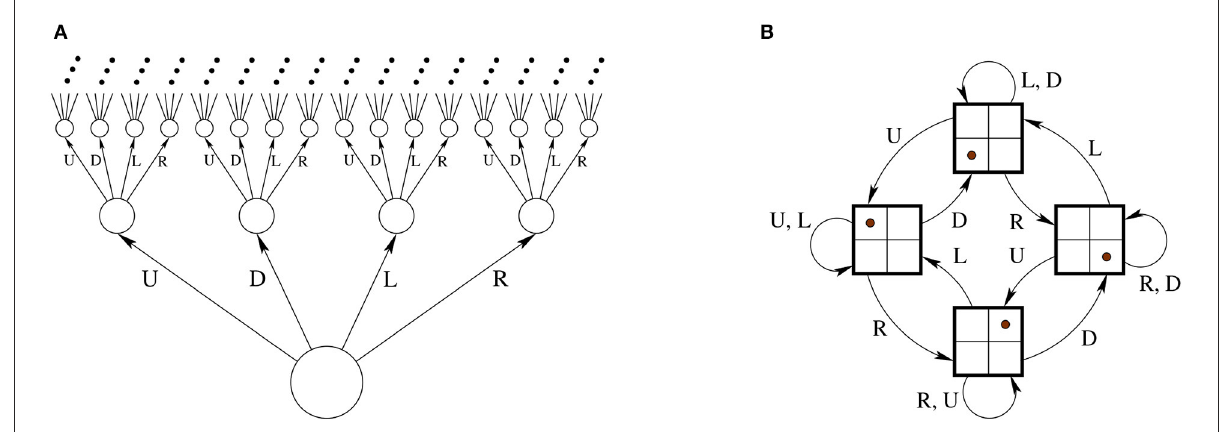
FIGURE3 (A) Having motor commands and no sensory feedback leads to an infinite tree automaton. (B) Once the body is coupled with a 2 × 2 grid environment, a four-state automaton